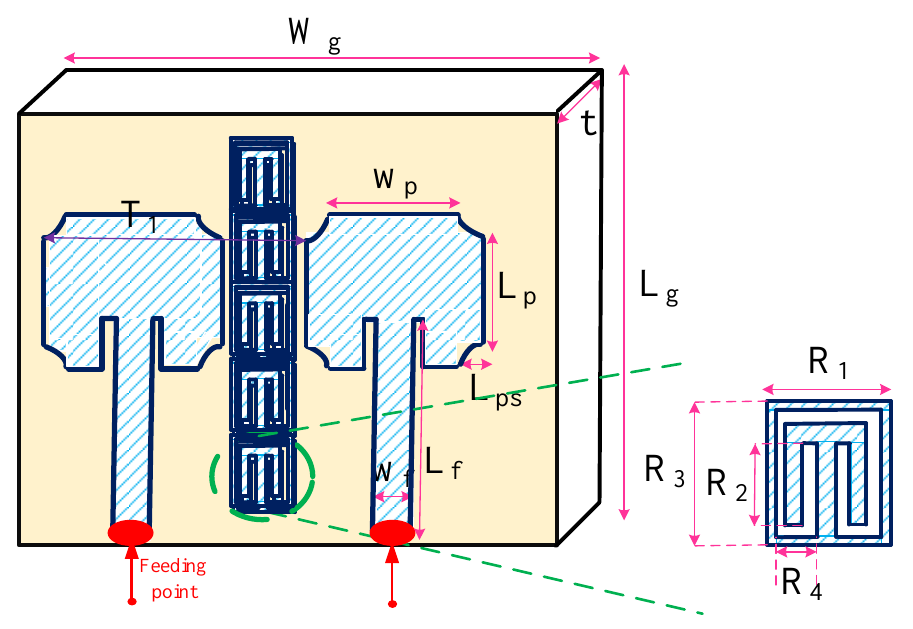
Figure 5. MIMO antenna structure. Table 2. Design parameters of optimized MIMO antenna in Figure